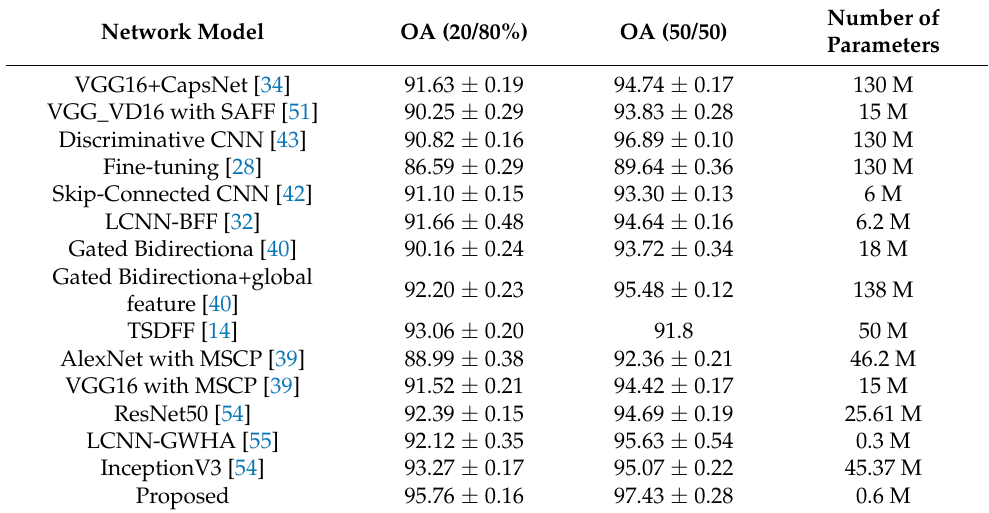
Table 4. Comparison of OA and parameters between the proposed method and some advanced methods on the AID dataset with 20% and 50% training